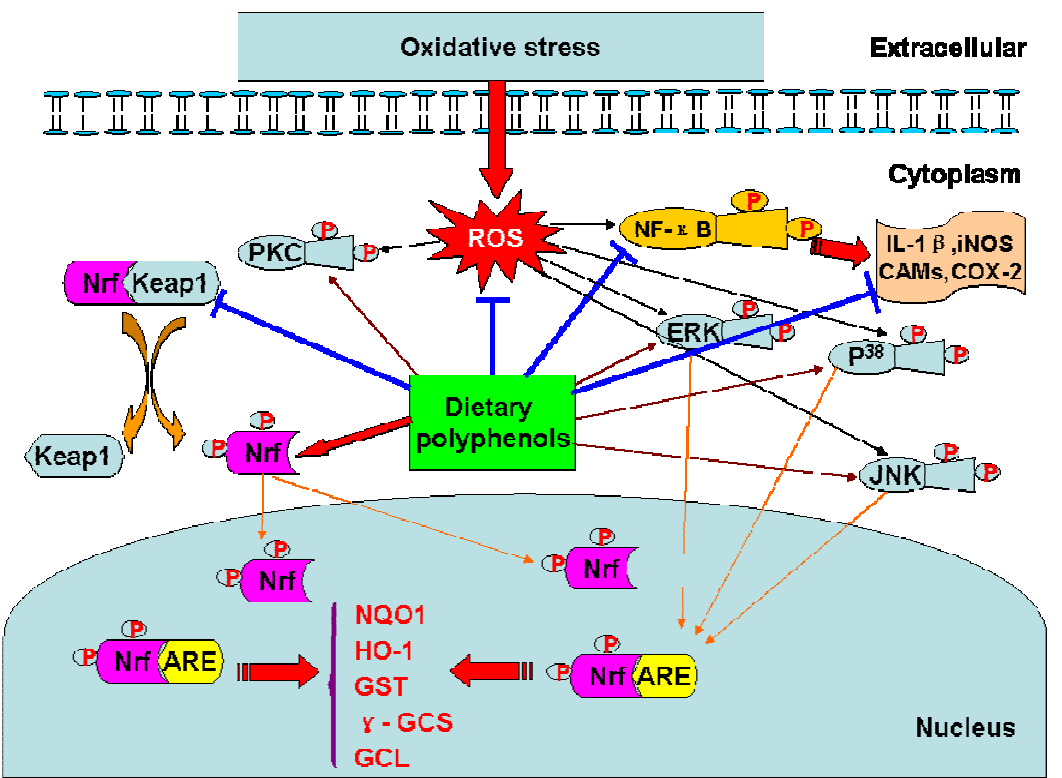
Figure 3. Mechanisms of the biological effects of dietary polyphenols.